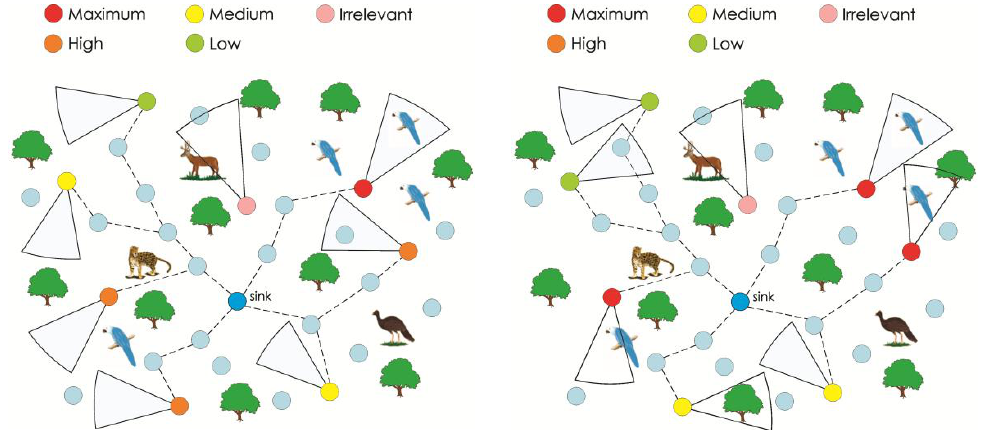
Figure 1. Different relevancies according to the application requirements and cameras’